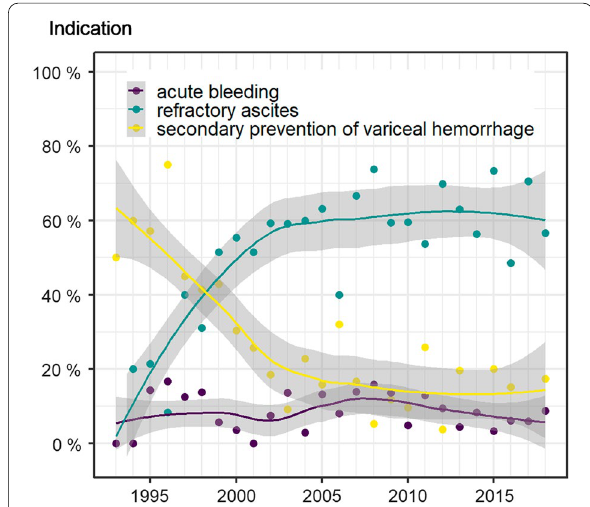
Fig. 3 TIPS indications. TIPS indications changed significantly over 25